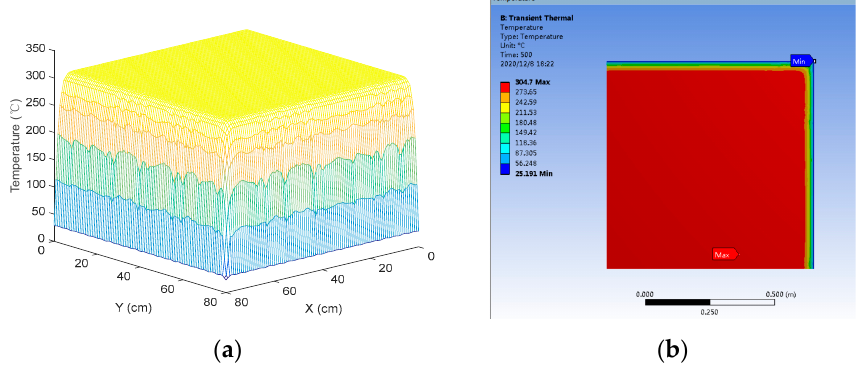
Figure 10. Heat transfer calculation results for the transient heat conduction problem (( a ) FEMN solution and ( b ) analytical solution).